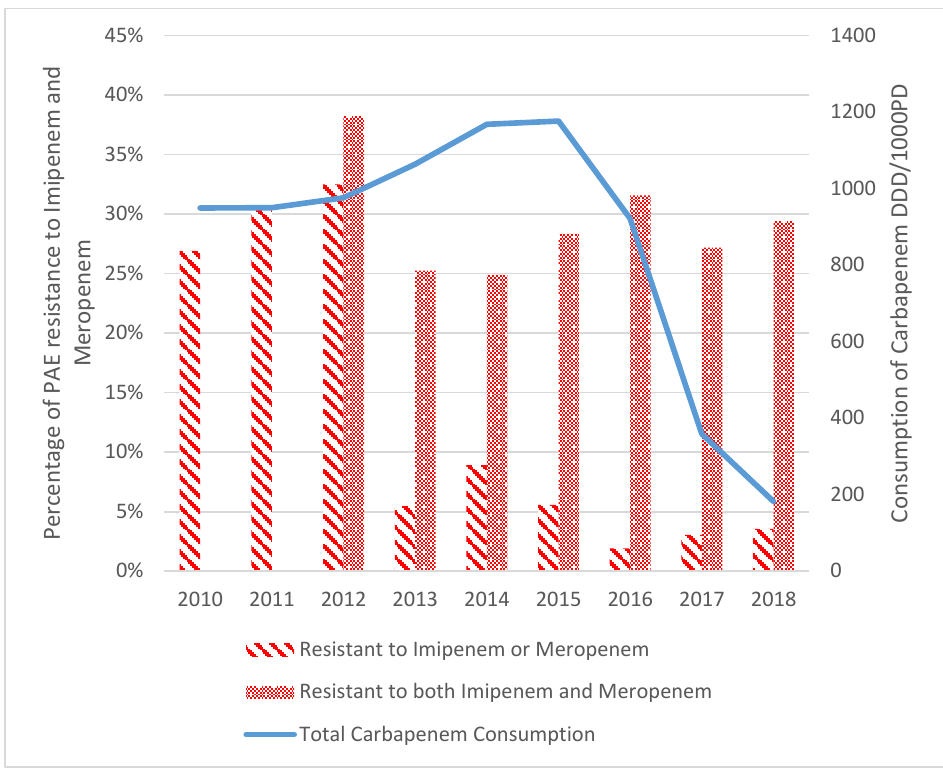
Figure 4. Change in consumption of carbapenems and resistance of Pseudomonas aeruginosa to MEM and IPM from 2010 to 2018.